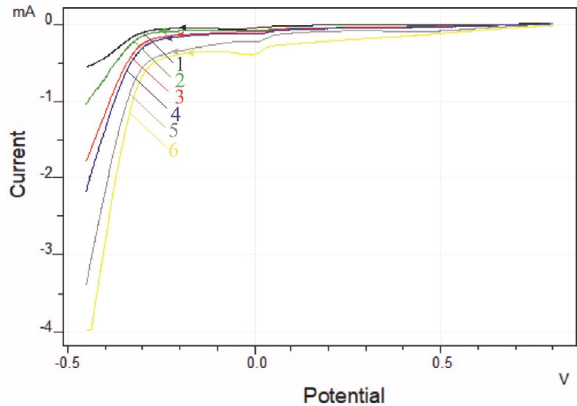
Fig. 5. The effect of potential-scanning to the electroreduction pro- cess of the molybdate ions on the Pt electrode. Electrolyte (М): 0,1 Na 2 MoO 4 2H 2 O + 0,007 C 4 H 6 O 6 . Potential-scanning (V/s): 1- 0,005; 2- 0,01; 3- 0,03; 4- 0,06; 5- 0,09; 6- 0,12. Т = 293